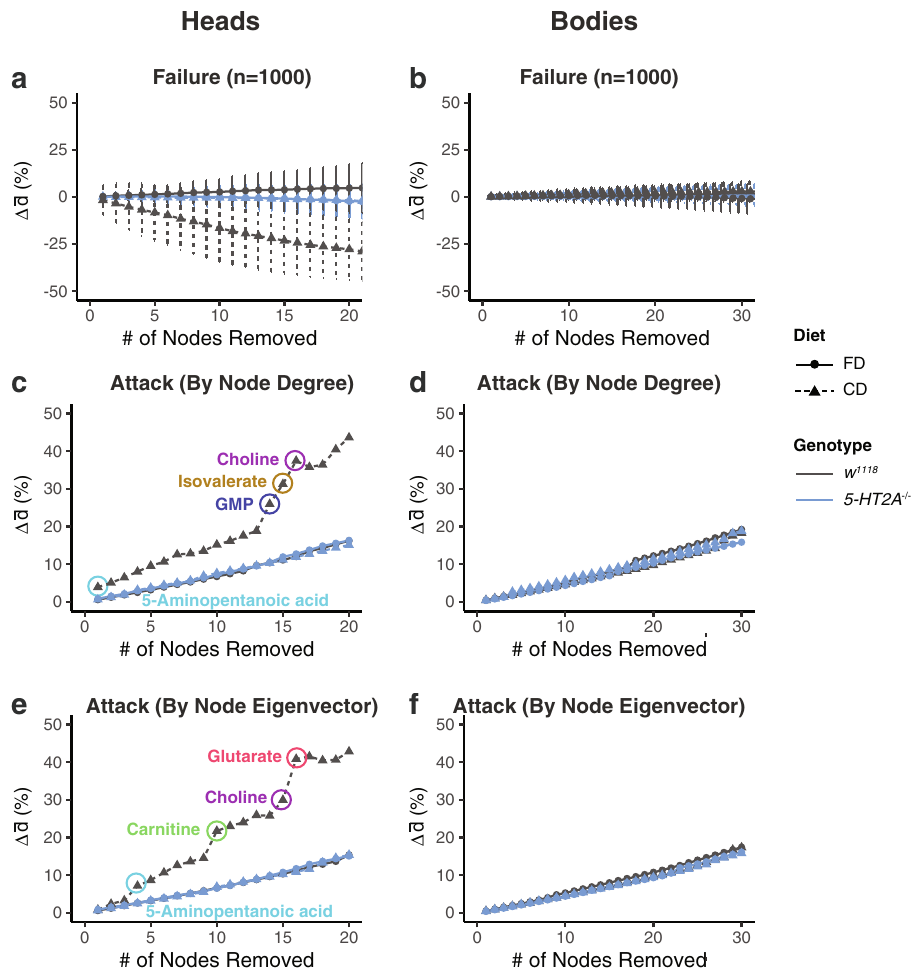
Fig. 5 Serotonin signaling mediates the decrease in network robustness in response to nutrient choice. a , b Randomly removing nodes in the networks does not increase average shortest distance in neither heads ( a ) nor bodies ( b ). Dots and error bars indicate the mean and standard deviation from 1000 simulations, respectively. c – f Sequential removals following node centrality (estimated from node degree ( c , d ) or node eigenvector ( e , f )) increase the average shortest distance ( (cid:1) d ) of correlation networks in both heads and bodies. Importantly, such increases are more signi fi cant in the heads of control fl ies that fed on a choice diet, suggesting this network is more vulnerable than other ones. Key metabolites that lead to the differences are highlighted in